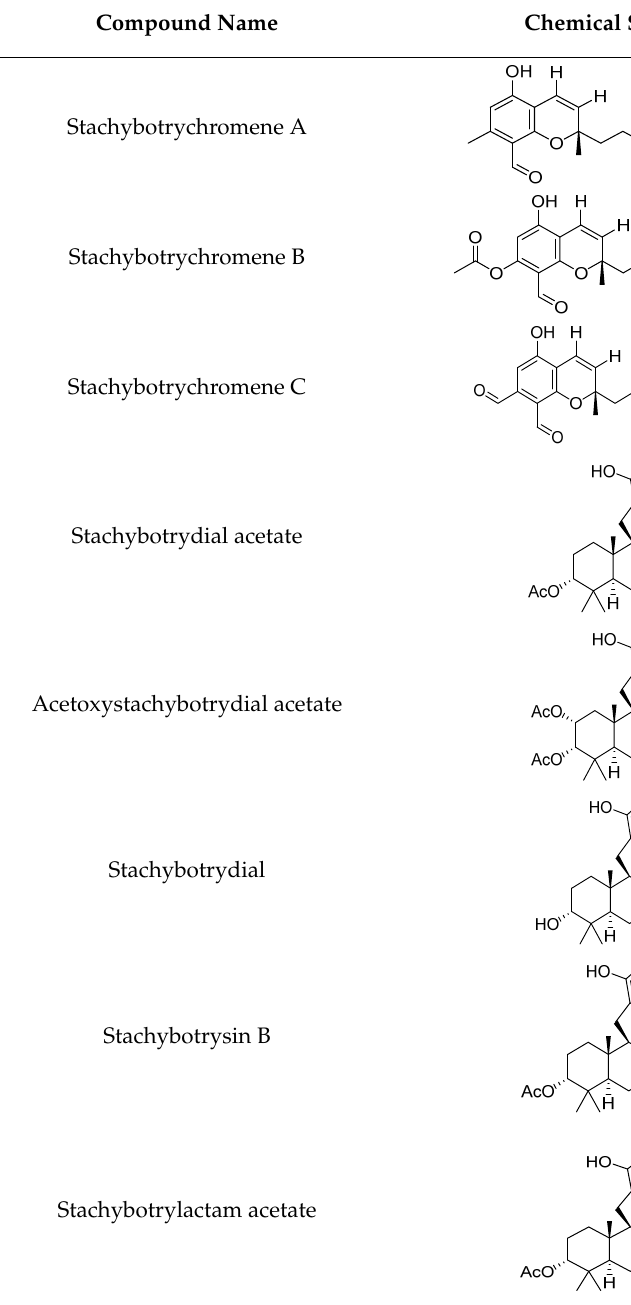
Table 1. Inhibition of human protein kinase CK2 by 14 natural compounds isolated from Stachybotrys chartarum .